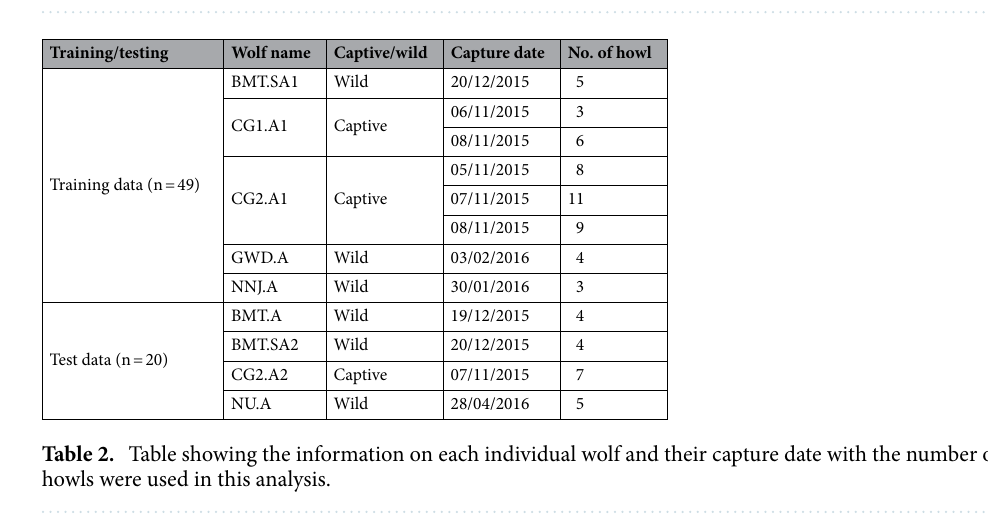
the wolves’ identities were not included in the model. The variables of these 20 howls were calculated from the equation of DFA of 49 howls for cluster analysis.